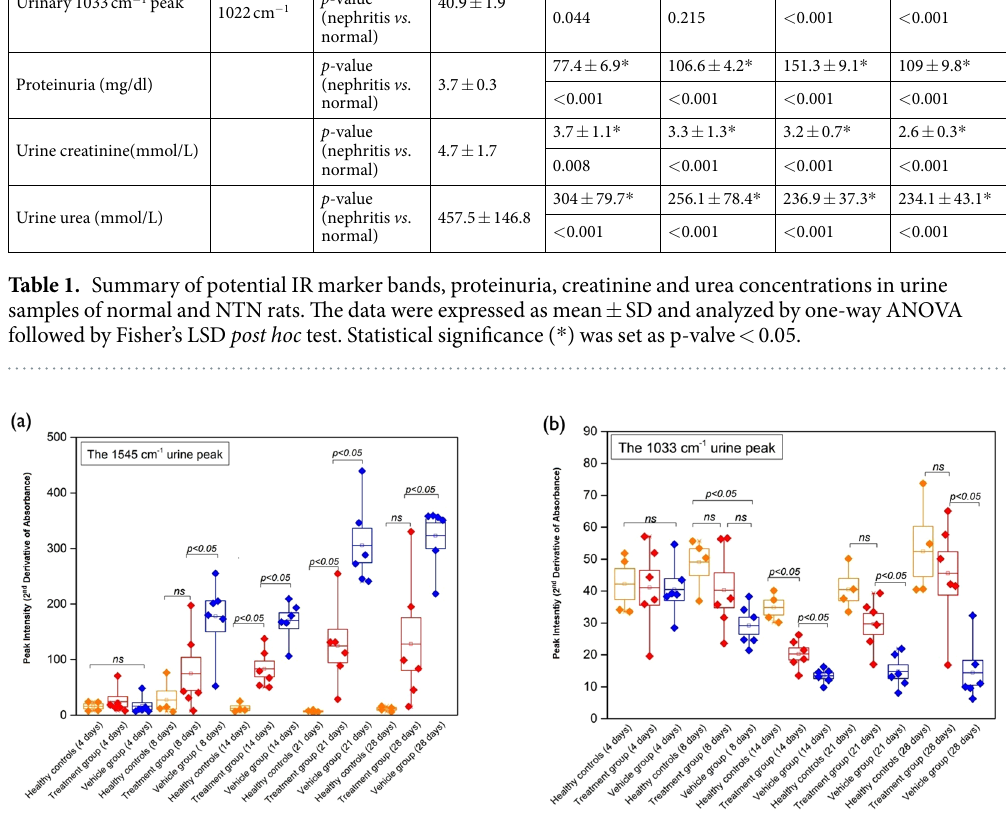
average normalized second derivative spectra of each nephritic group with that of the healthy control revealed six features of interest as possible markers to distinguish normal from nephritic groups Fig. 3(a) and (b). Integrated areas of these features were obtained from individual samples [i.e. normal rats (n = 34), day 8 NTN rats (n = 20), day 14 NTN rats (n = 18), day 21 NTN rats (n = 17) and day 28 NTN rats (n = 18)]. The results were then ana- lyzed by a pairwise principal component analysis (PCA) for exploration of the most significant spectral responses